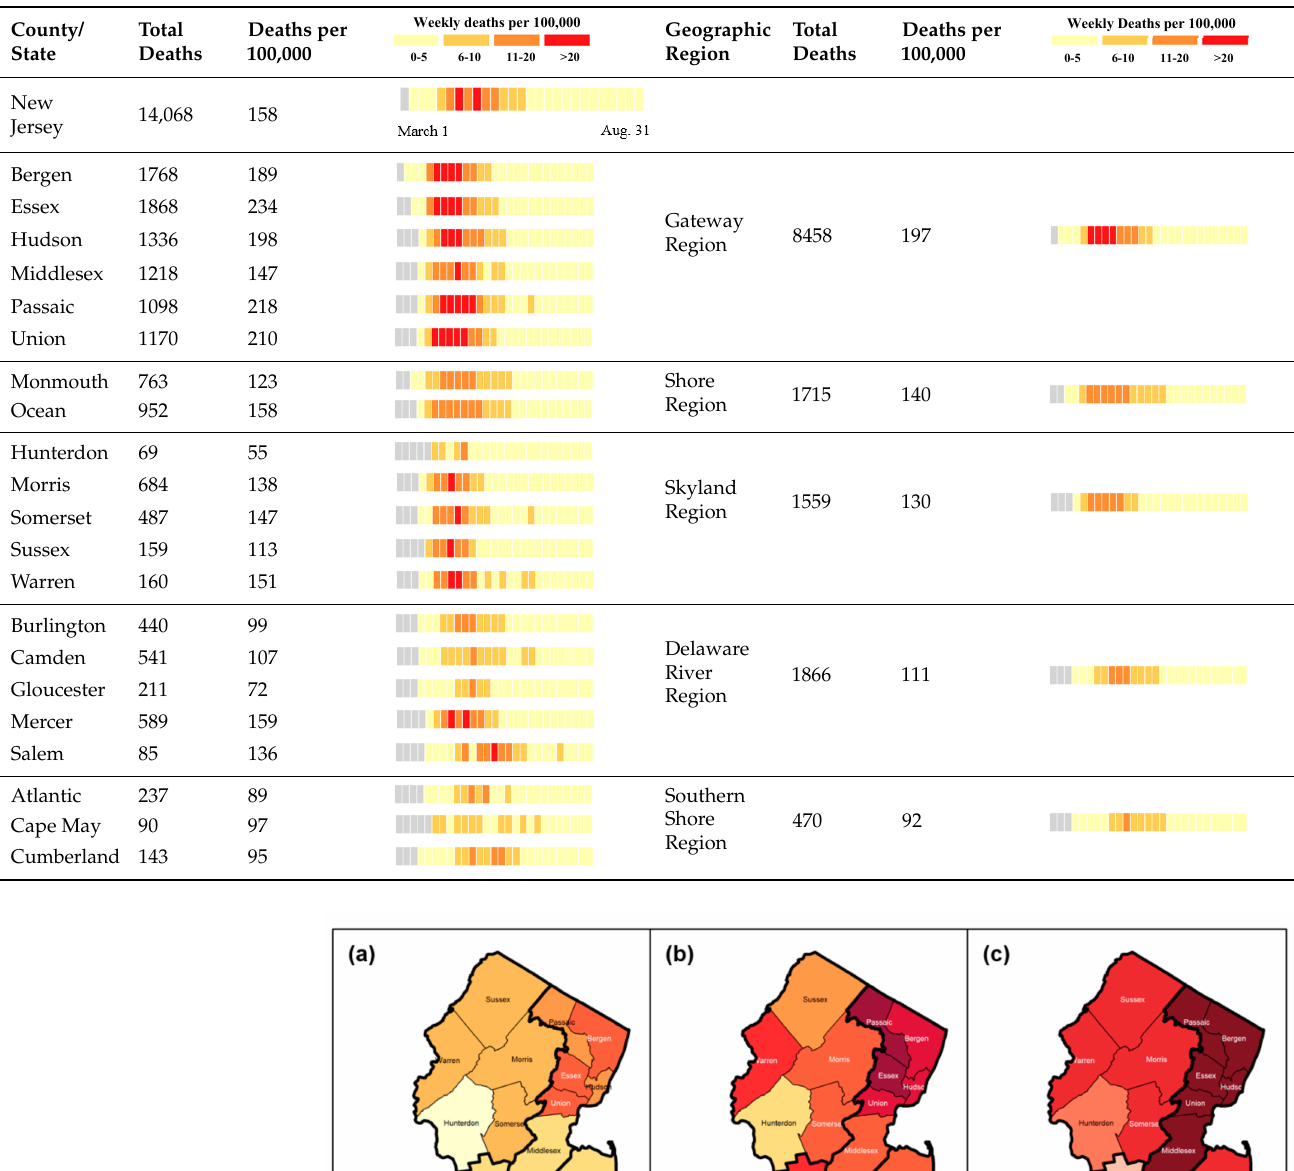
Table 1. COVID-19 confirmed deaths per 100,000 residents by August 31 2020 across New Jersey. The color bars in the time strip denote the weekly deaths per 100,000 people.